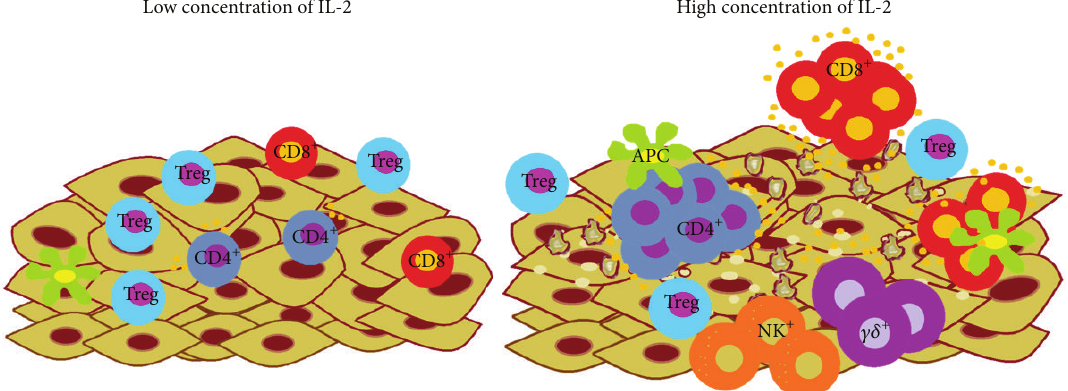
Figure 2: Concentration of IL-2 and activation of tumour-infiltrating lymphocytes. Low concentrations of IL-2 may promote the regulatory microenvironment and tumour growth. High concentrations of IL-2 activate immune system cells, such as CD8 + , CD4 + , and 𝛾𝛿 T cells and NK cells; these cells produce proinflammatory cytokines, such as IFN- 𝛾 , and eliminate tumour